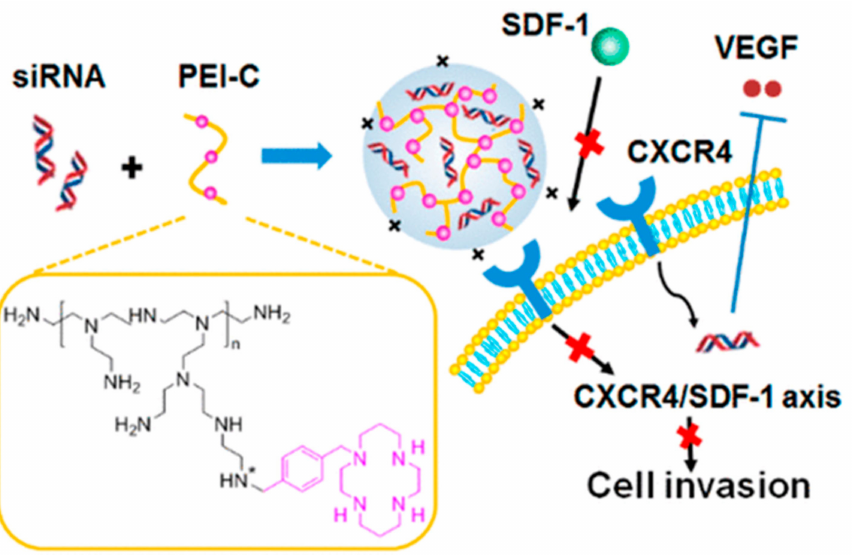
Figure 5. The mechanism of action of PEI-C/siVEGF polyplexes. Reprinted with permission from Zhou et al. [100]. Copyright (2018) American Chemical